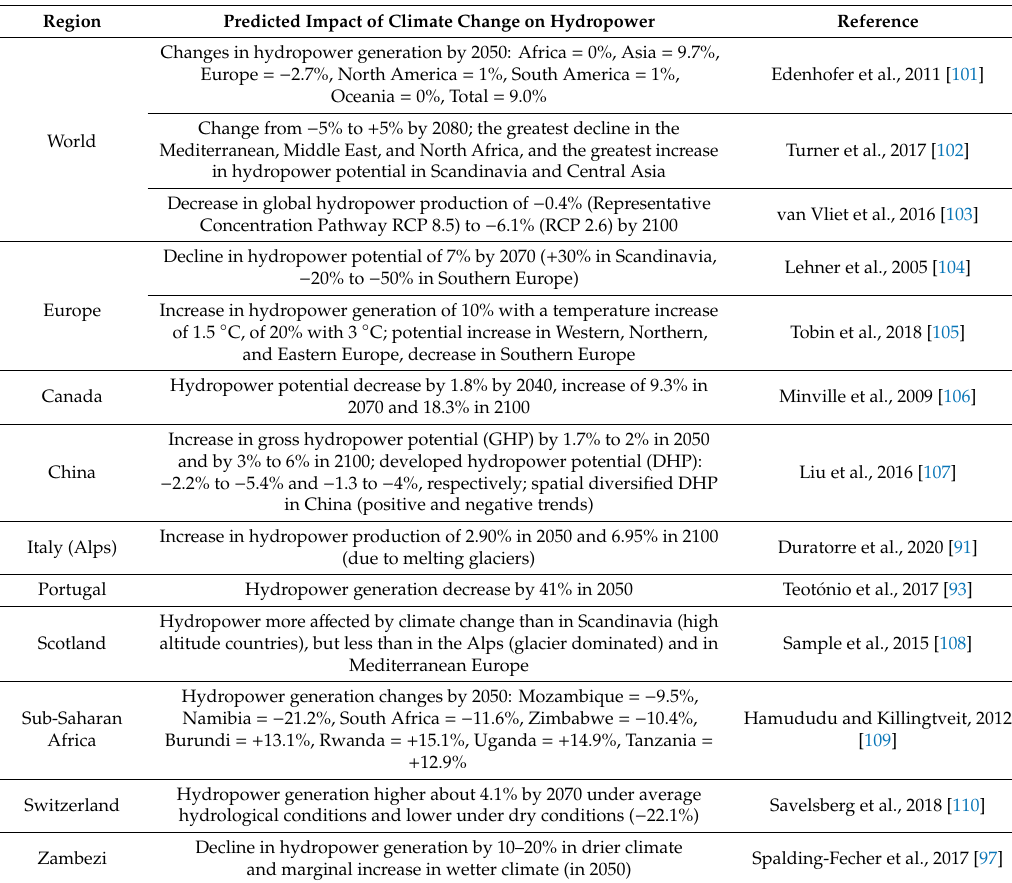
Table 2. Summary of the expected impact of climate change on the hydropower sector in various regions of the world on the basis of a literature